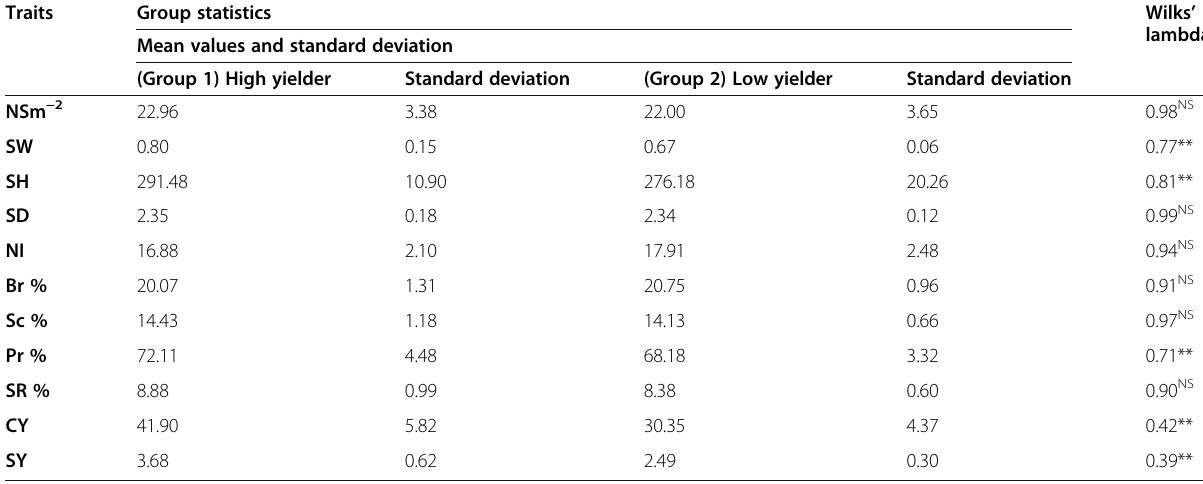
Table 6 Comparing between the two supposed groups (high and low yielder genotypes) using a test of equality of group means Traits Group